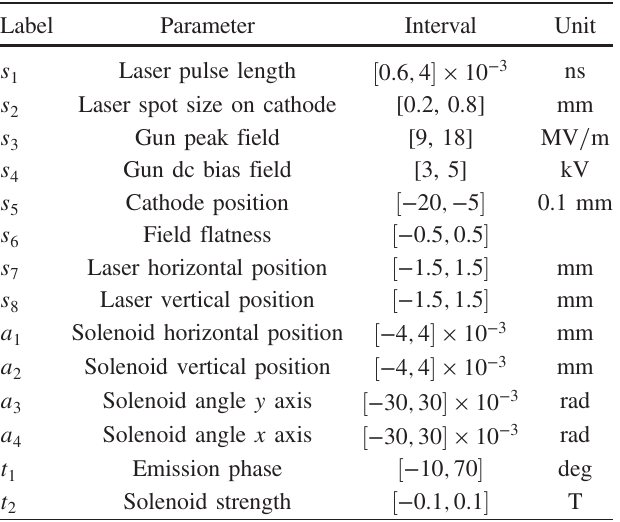
TABLE I. Parameters and their ranges for the ASTRA simu- lations. All values are chosen randomly from a uniform distri- bution of the specified interval. Fixed values: Bunch charge scale: 0.1 pC, solenoid position in respect to the cavity in z axis: 0.4625 m, stop position of tracking: 1.737 m longitudinal offset of the input distribution like gun peak field but multiplied with 10 − 4 . The state parameters are s ≔ ½ s ; … ; s 1 8 (cid:2) , the action param-